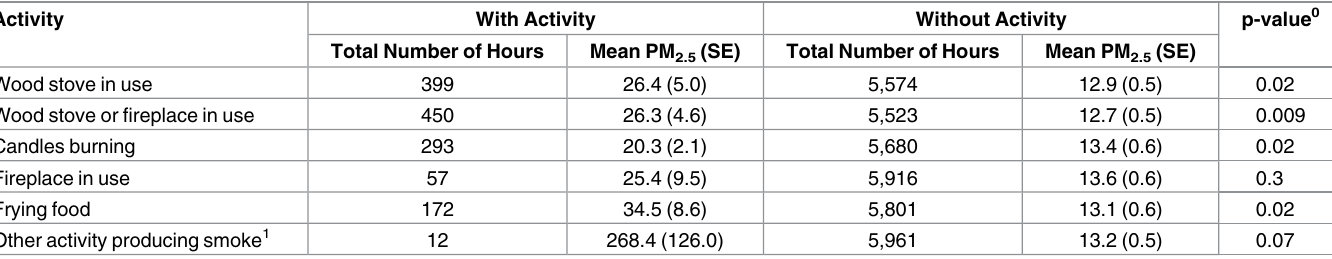
Table 2. Mean Hourly PM 2.5 Levels ( μ g/m 3 ) Recorded by Monitor During Hours With and Without Activities that Could Generate Particulate